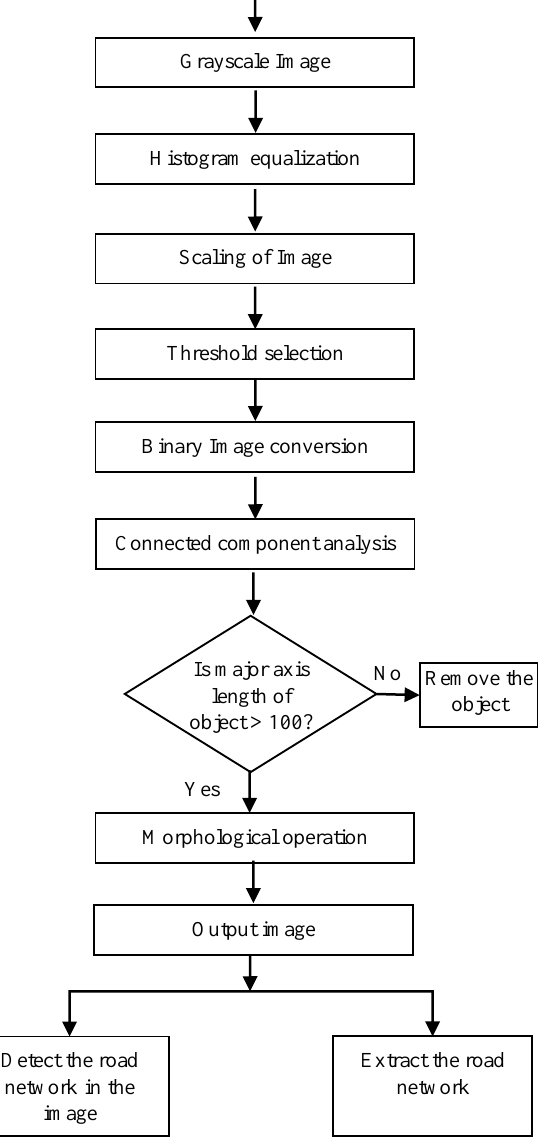
Figure 1: Road detection and extraction methodology into binary image and it contains only black and white